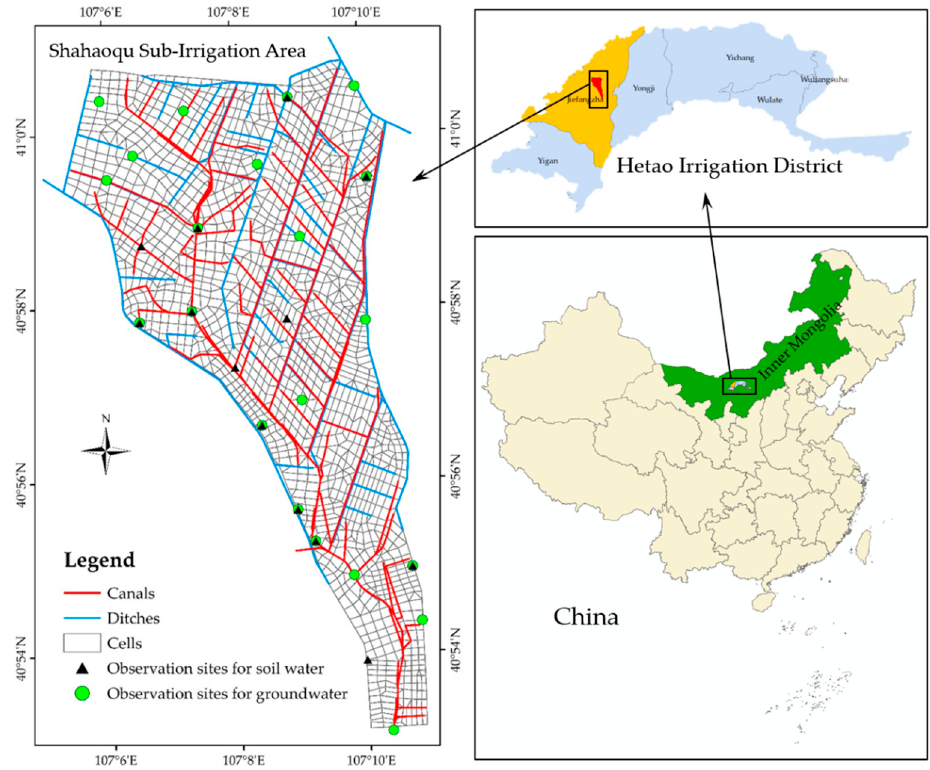
Figure 6. Location of Shahaoqu Sub-Irrigation Area and the distribution of canals, ditches, cells, and observation sites for soil water and groundwater.